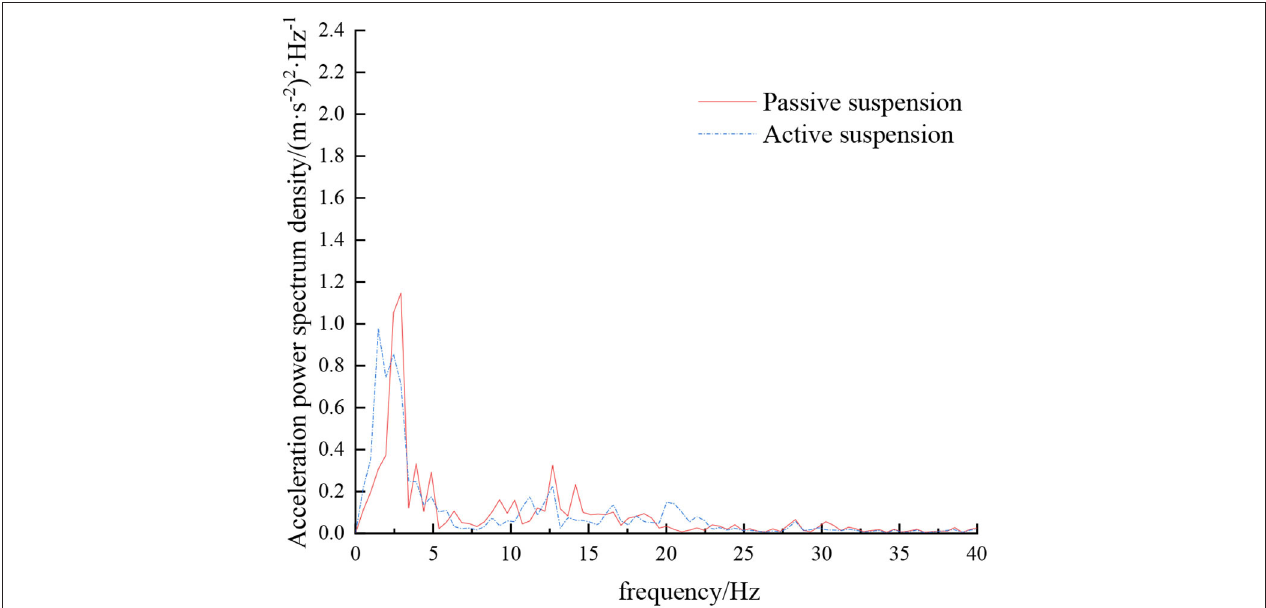
FIGURE 15 | Frequency domain response curve when driving at 8km/h on sand-gravel